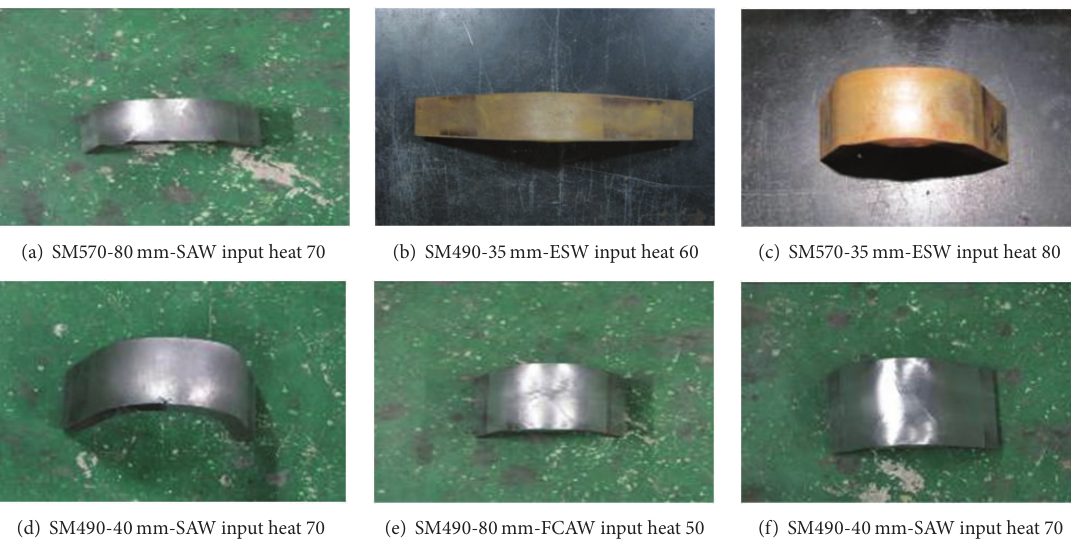
Figure 6: Side face bending test result of SM490TMCP and SM570TMCP.